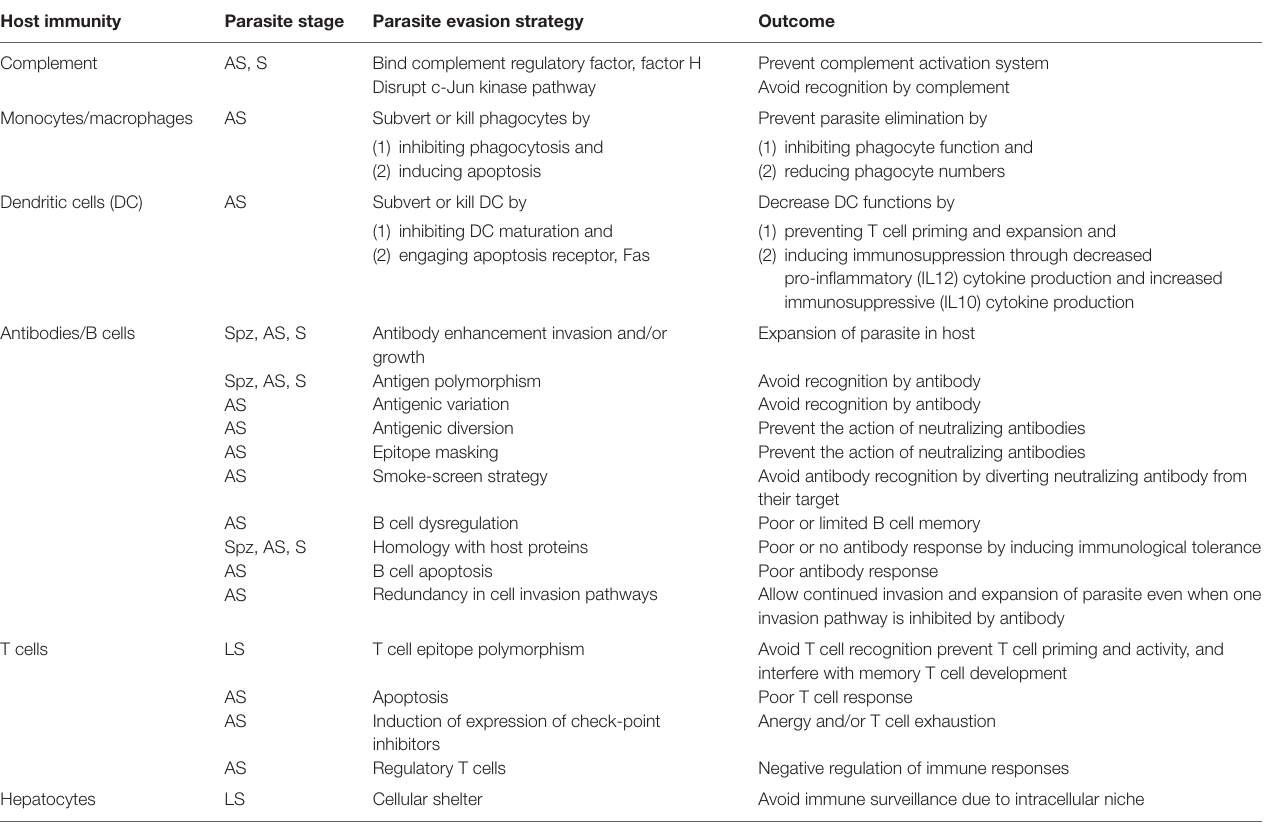
TABLe 1 | Host immunity and parasite immune escape